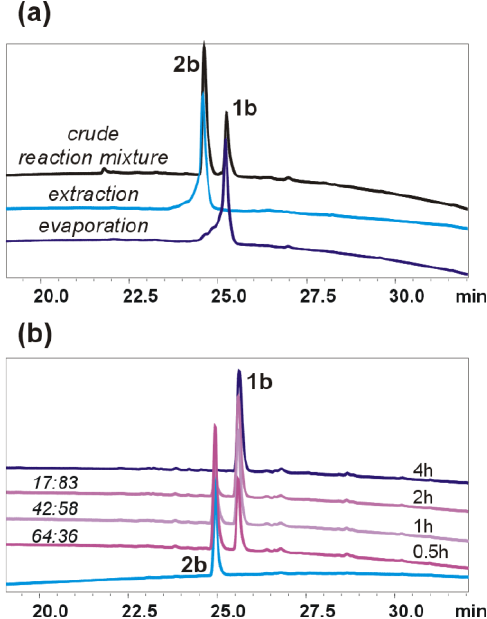
Figure 2. ( a ) Dependence of the products of the reaction on the work-up method. ( b ) Stability studies of compound 2b at 45 °C under alkaline conditions.